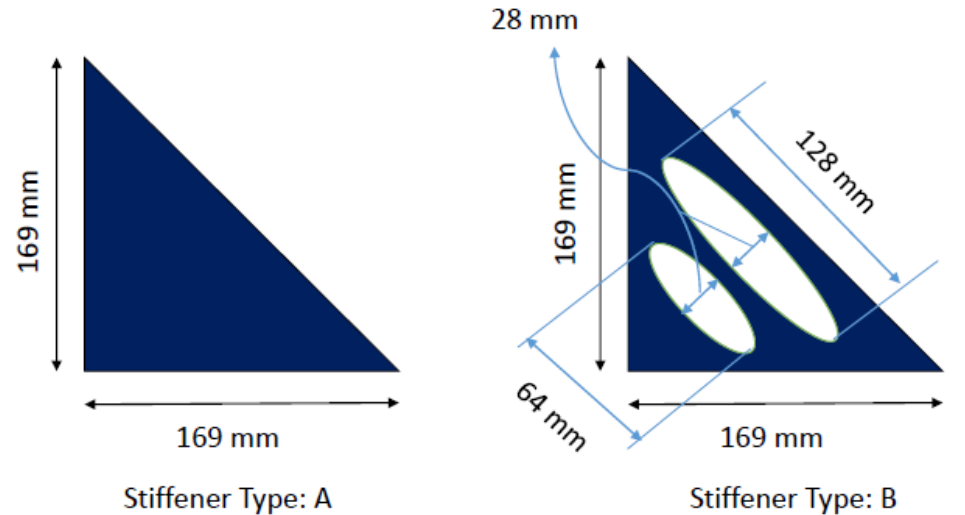
Figure 10. ( A , B ) Geometric dimensioning of stiffener types.